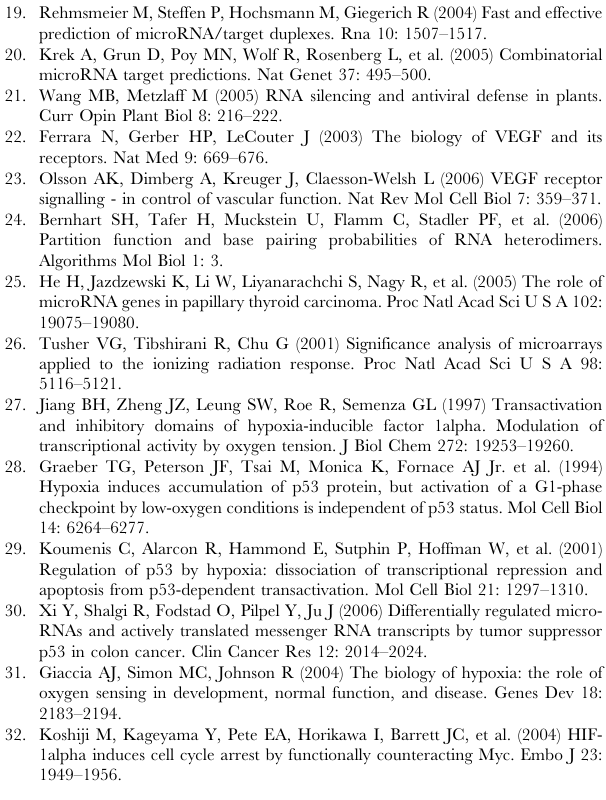
Table S1 RNAhybrid, miRanda, and FindTar were used to predict potential binding sites of each human miRNA. The sites found by two or all of these three software were chosen as putative binding sites for miRNAs (all these sites were predicted by FindTar). Free energy is calculated by RNAcofold.